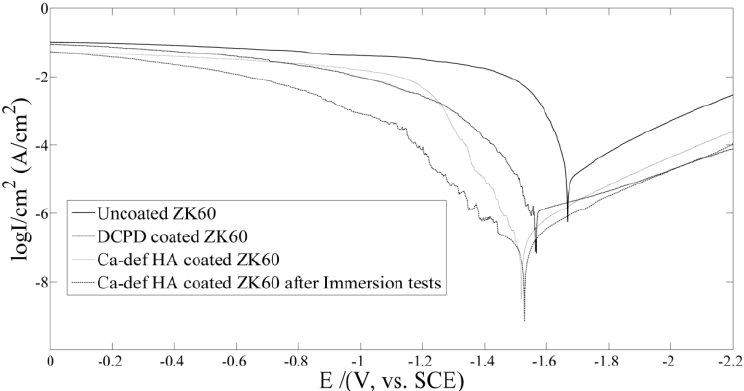
Figure 7. Potentiodynamic polarization curves of the samples obtained in SBF at 37